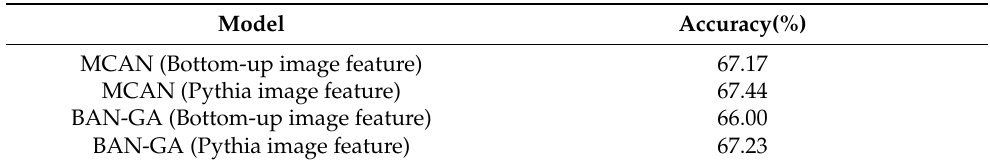
Table 1. The results of MCAN and BAN are used for the two image features, which are extracted by BUTD and Pythia